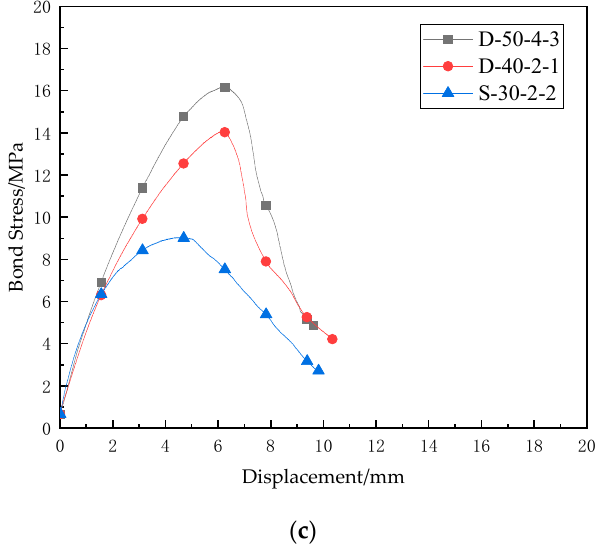
Figure 6. Bond-slip curves of different failure mode ( a ) bar pull-out failure (smooth regular CFRP bar) ( b ) bar pull-out failure (double ribbed CFRP bar) ( c ) concrete splitting failure.